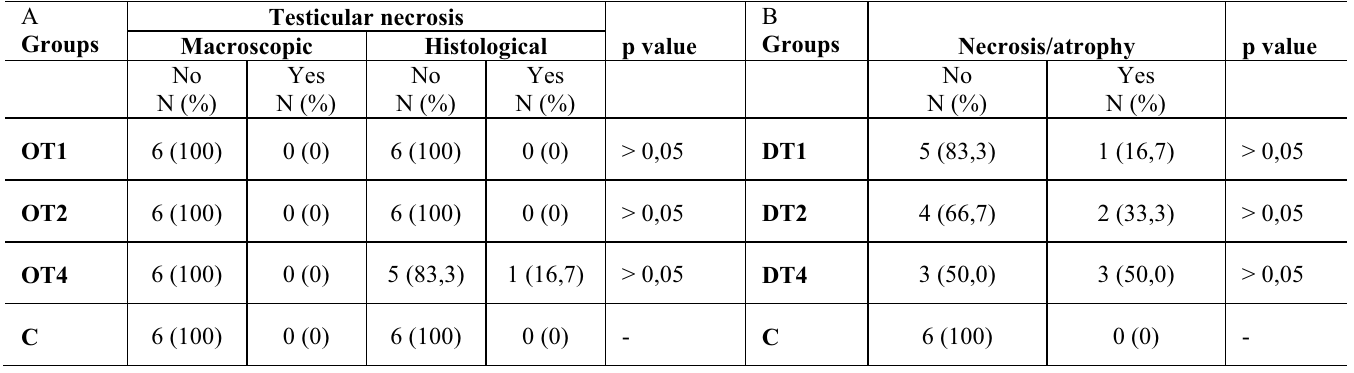
TABLE 2 – A . Presence of ipsilateral testicular necrosis in the groups of rats undergoing orchiectomy in comparison with control group; B . Presence of ipsilateral testicular necrosis/atrophy in the groups of rats undergoing detorsion of the spermatic cord in comparison with control